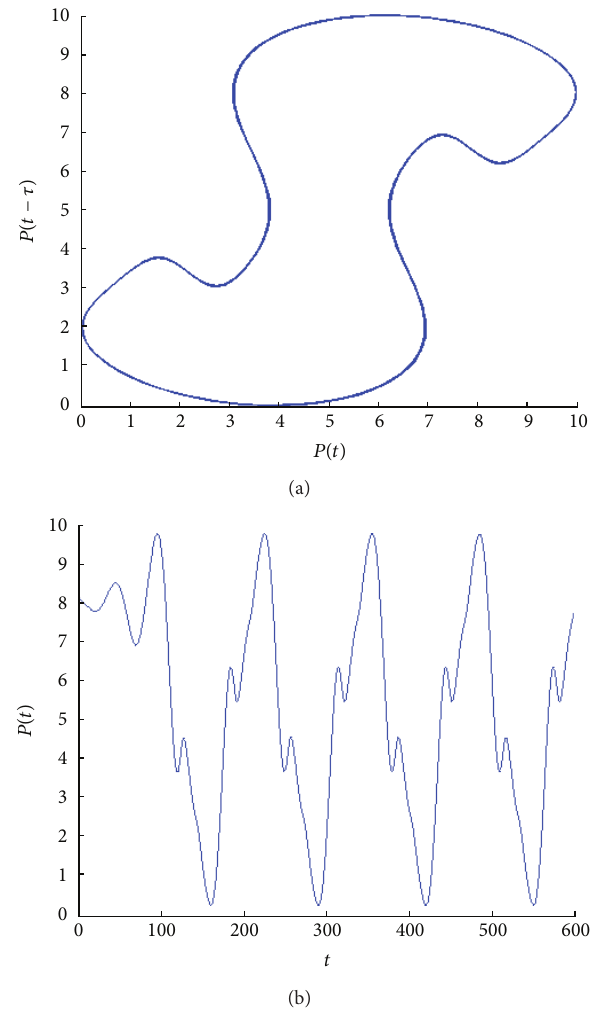
Figure 4: 𝜏 = 14.3 . (a) A unique attractor generated by the global bifurcation. (b) Corresponding time series with large oscillations.